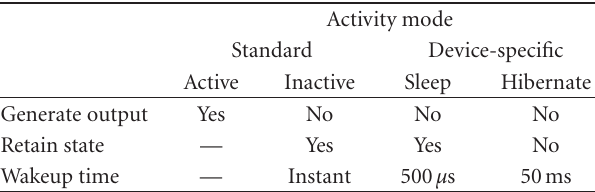
Table 2: Examples of activity modes. The first two modes are fixed, further modes can be defined based on the device